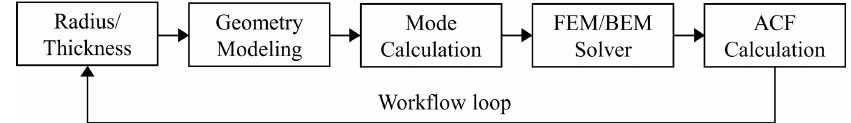
Figure 16. Optimization workflow with the variation in the thickness t and the radius r of the separation plate